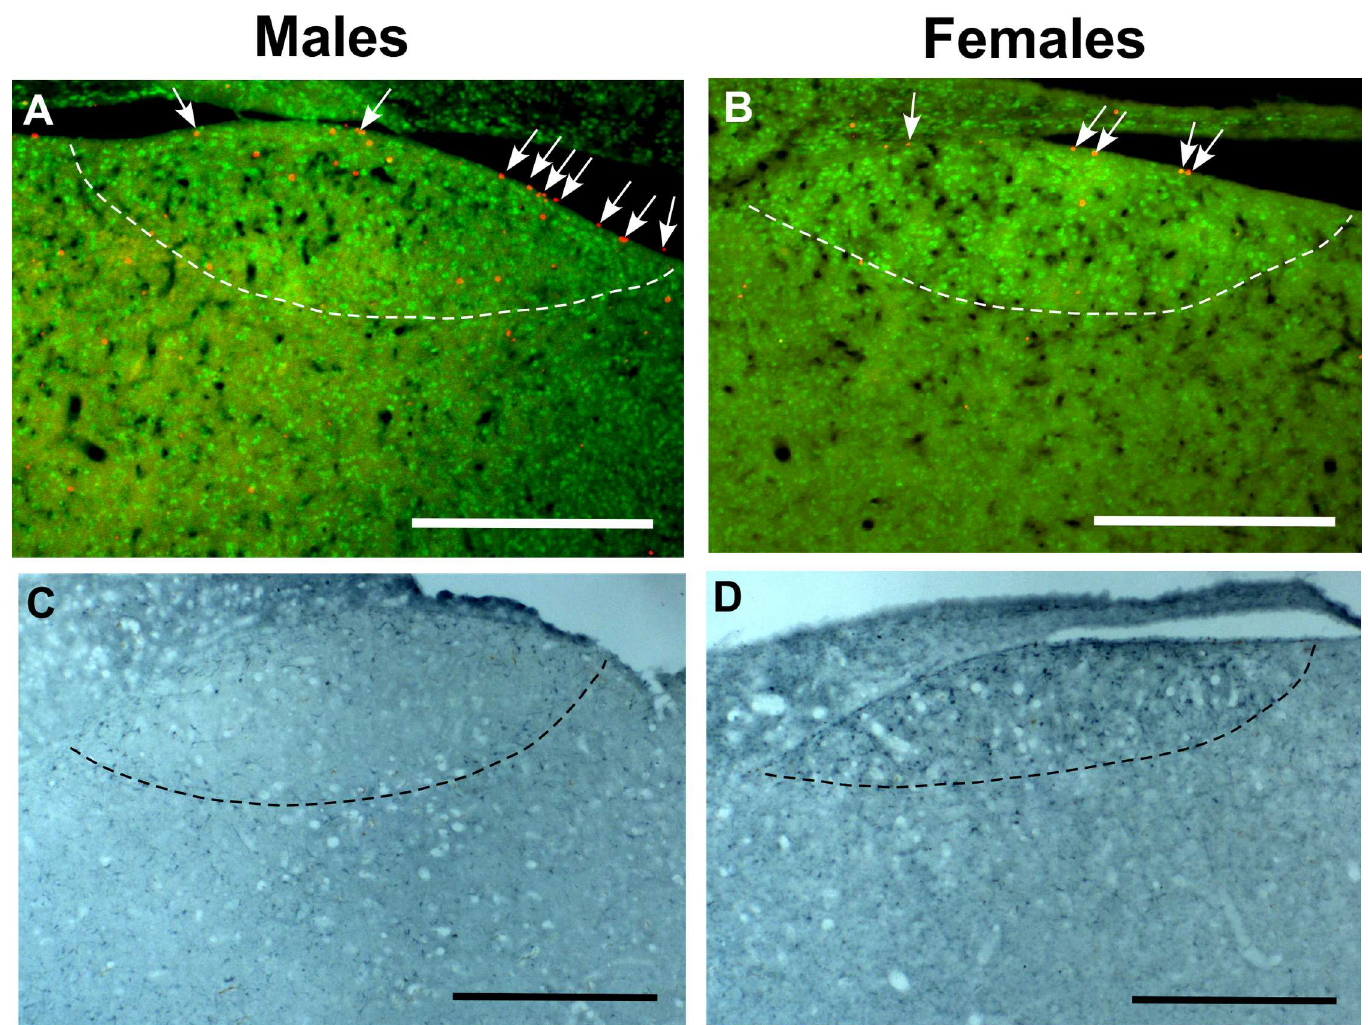
Fig 5. Photomicrographs illustrating the sex difference in numbers of EdU+ cells in the VZ dorsal to HVC (A-B; Males > Females) and in the number of DCX+ neurons in HVC (C-D; Females > Males). In panels A-B, EdU+ cells (white arrows) were labeledin red by the Click-IT reactionwhile the limits of HVC were identified by the higherdensity of Hu+ cells labeledin green. In all panels,the ventral edgeof HVC is indicatedby a dotted line. The magnification bars are set at 500 μ